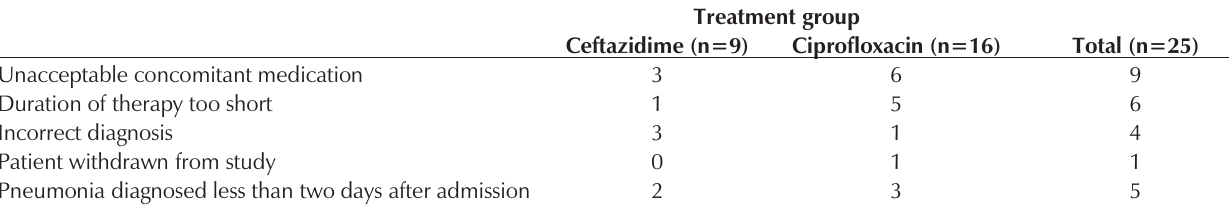
Treatment group